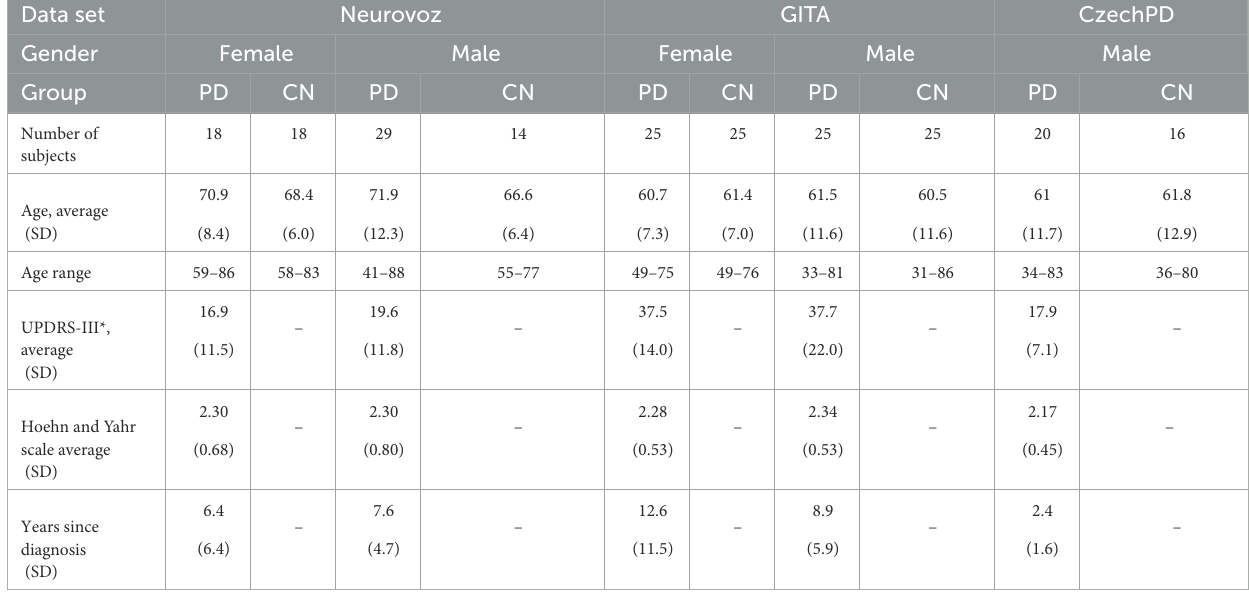
TABLE 3 Demographic and disease severity statistics of Neurovoz, GITA, and CzechPD data sets. Data